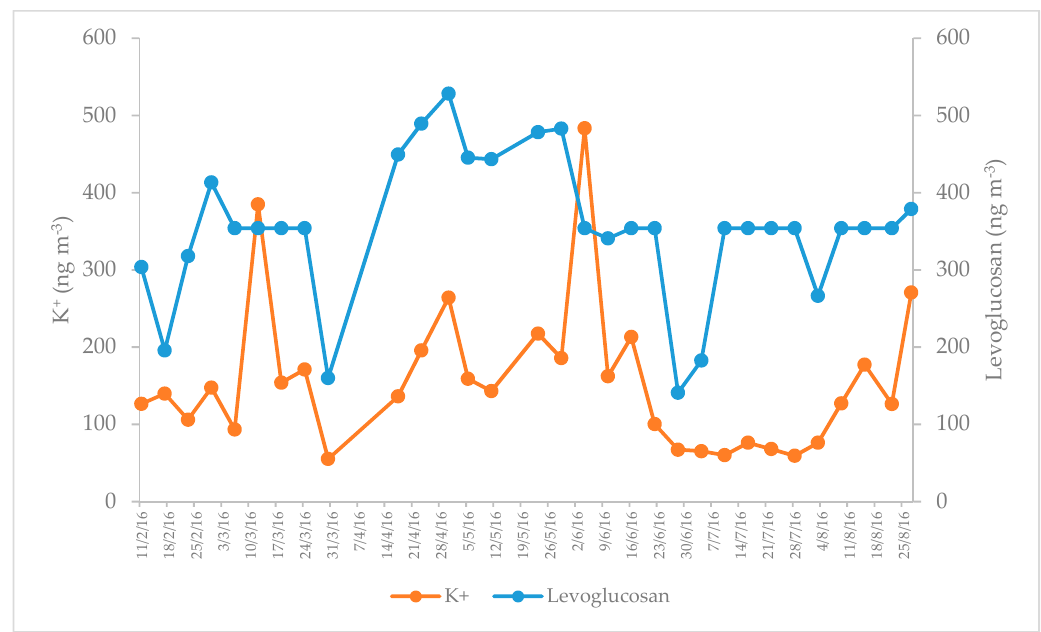
Figure 5. Association between water-soluble potassium and levoglucosan.